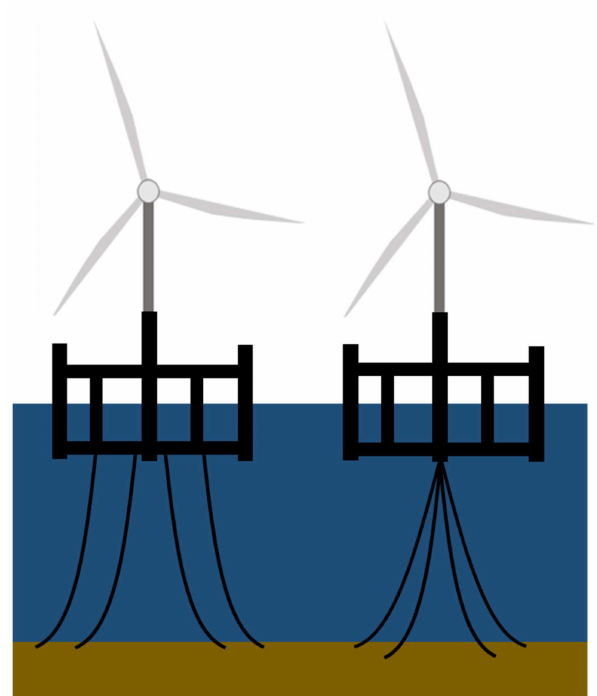
Figure 2. Schematic diagram of the MPM and SPM